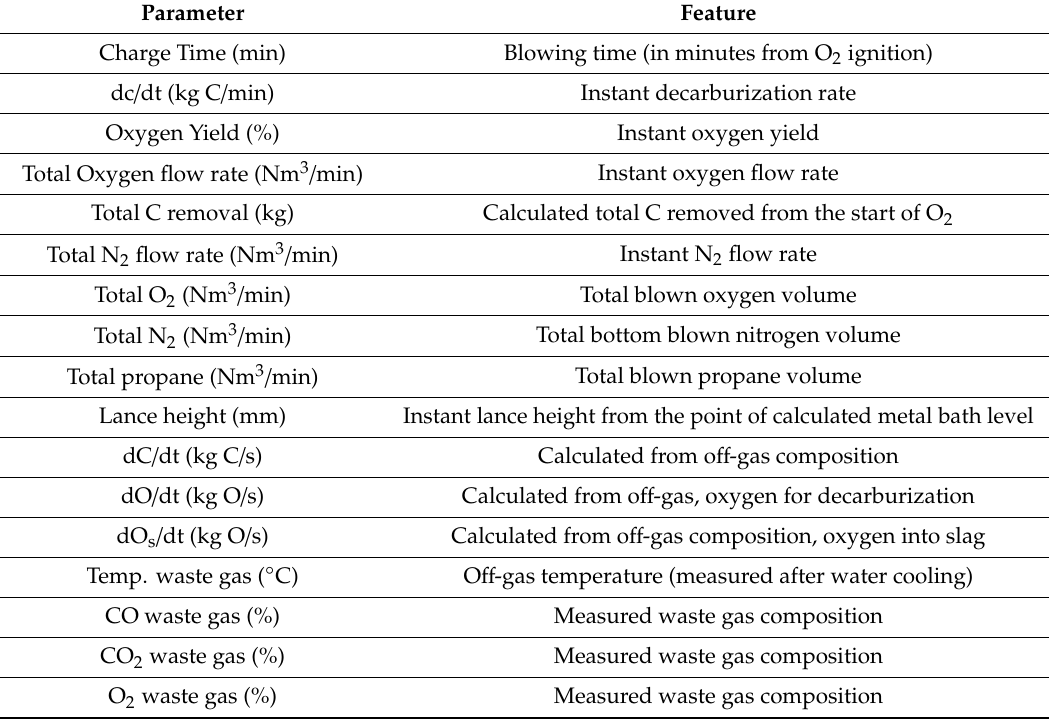
Table 1. The operating parameters and their features obtained from the six-ton pilot plant BOF converter